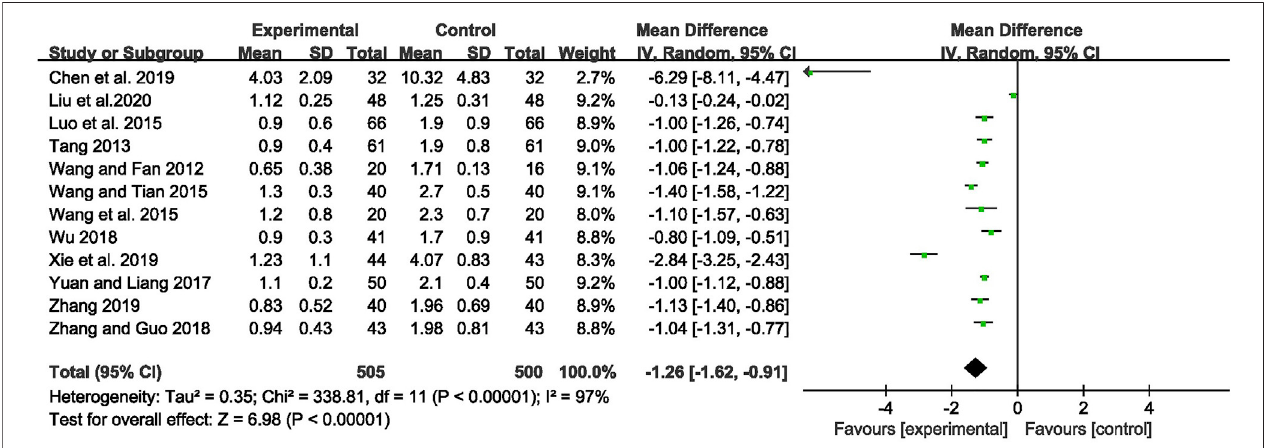
FIGURE 3 | Forest plot displaying the effects of CHM+AEDs vs. AEDs for monthly seizure frequency in patients with IE.